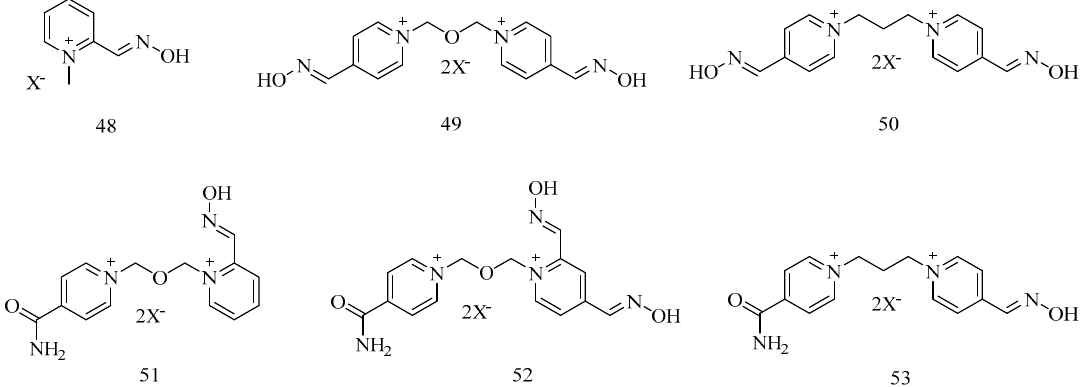
Figure 14. Oximes clinically used as antidotes for organophosphorus poisoning. X = chloride, mesylate or iodine for 48, chloride for 49, bromide for 50 and 53, chloride or mesylate for 51 and 52.